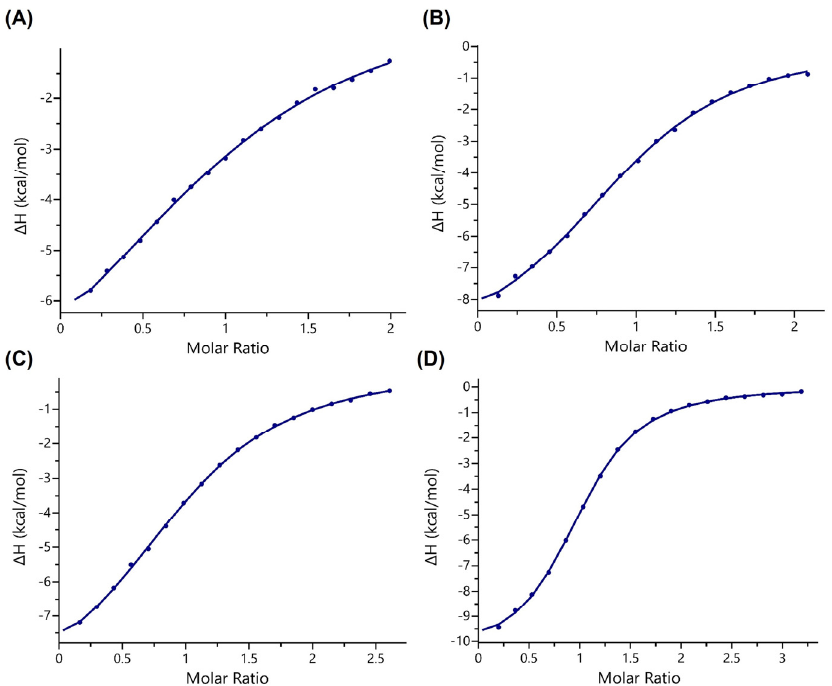
Figure 2. Representative ITC binding curves of AF9 YEATS titrated by methacrylated and crotonyl- ated H3K18 and H3K9 peptides. ( A ) H3K18mea, ( B ) H3K18cr, ( C ) H3K9mea, and ( D ) H3K9cr.